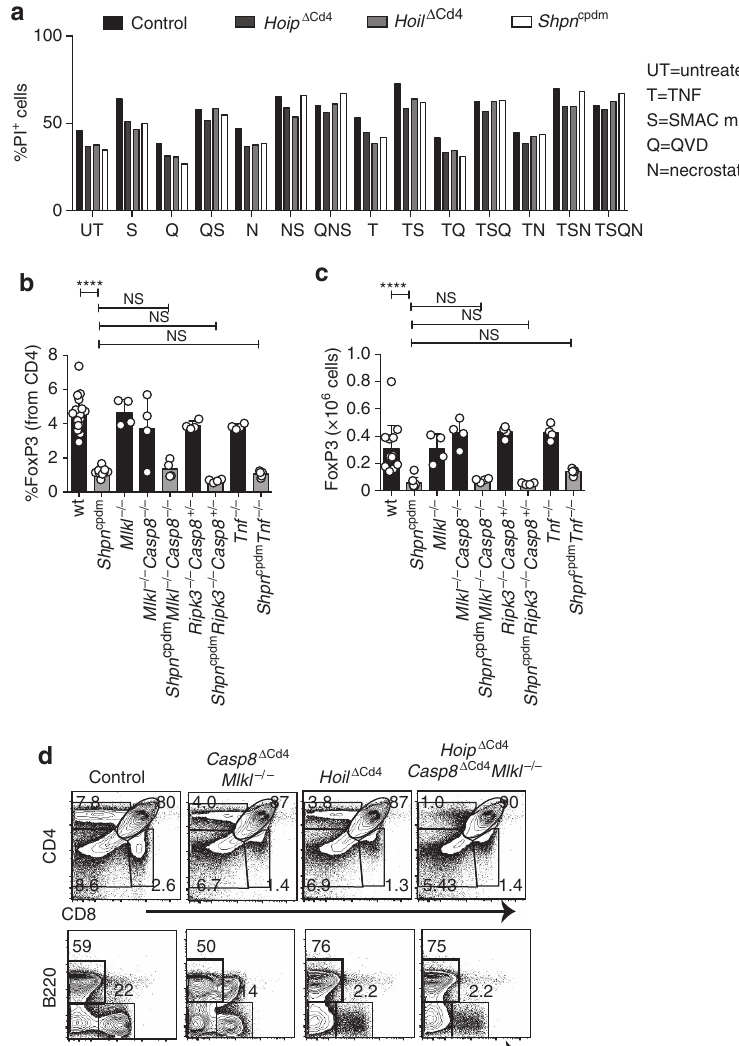
Figure 5 | Inhibition of cell death in LUBAC-deficient thymocytes. ( a ) Cell death determined by PI uptake in thymocytes from control, Hoip D Cd4 , Hoil D Cd4 and Sharpin cpdm mice cultured for 24h with combinations of agonists (T: 100ngml (cid:2) 1 TNF; S: 500nM SMAC mimetic; Q:10 m M QVD-OPh;N: 10 m M necrostatin). Percentages ( b ) and absolute numbers ( c ) of CD4 þ FOXP3 þ cells in the thymus of WT ( n ¼ 18), Sharpin cpdm ( n ¼ 11), Mlkl (cid:2) / (cid:2) ( n ¼ 4), Mlkl (cid:2) / (cid:2) Casp8 (cid:2) / (cid:2) ( n ¼ 4), Sharpin cpdm Casp8 (cid:2) / (cid:2) Mlkl (cid:2) / (cid:2) ( n ¼ 4), Rip3k (cid:2) / (cid:2) Casp8 þ / (cid:2) ( n ¼ 4), Sharpin cpdm Rip3k (cid:2) / (cid:2) Casp8 þ / (cid:2) ( n ¼ 4), Tnf (cid:2) / (cid:2) ( n ¼ 4) and Sharpin cpdm Tnf (cid:2) / (cid:2) ( n ¼ 5) mice. Shpn cpdm refers to Sharpin cpdm mice. ( d ) Surface expression of CD4 and CD8 on whole thymocytes from control, Casp8 D Cd4 Mlkl (cid:2) / (cid:2) , Hoil D Cd4 and Hoip D Cd4 Casp8 D cd4 Mlkl (cid:2) / (cid:2) mice. Data are representative of two independent experiments with one mouse per genotype ( a , d ). For b and c , each symbol represents an individual mouse, with 4–14 mice per group; small horizontal lines indicate mean ± s.d.; * P o 0.05, ** P o